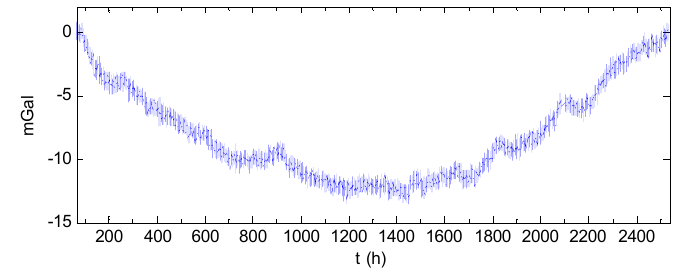
Figure 11. Result after the drift was compensated using a linear curve (after subtracting the starting